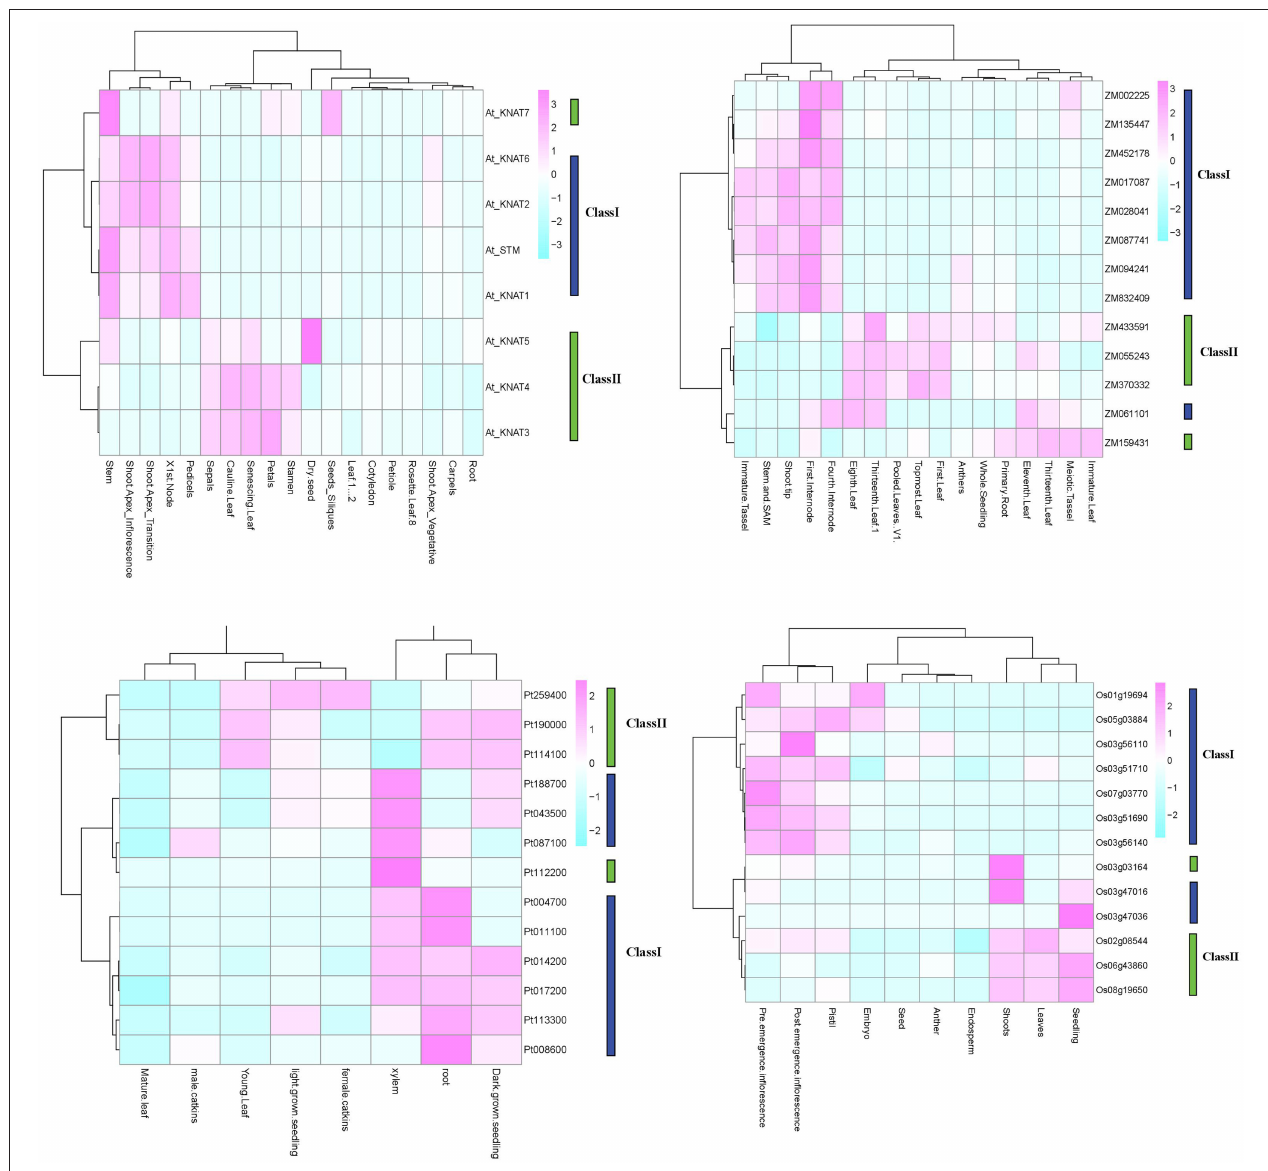
FIGURE 5 | KNOX expression in four species. Expression profiles for O. sativa , Z. mays , P. trichocarpa , and A. thaliana are shown. Analyses are based on publically available microarray data. The Arabidopsis and Populus microarray gene expression data were obtained from AtGenExpress and poplar eFP. The public expression data in Zea mays were obtained from the Plant Expression Database (PLEXdb, http://www.plexdb.org/). The rice expression, we used RNA-seq data from the Michigan State University (MSU) Rice Genome Annotation (http://rice.plantbiology.msu.edu)